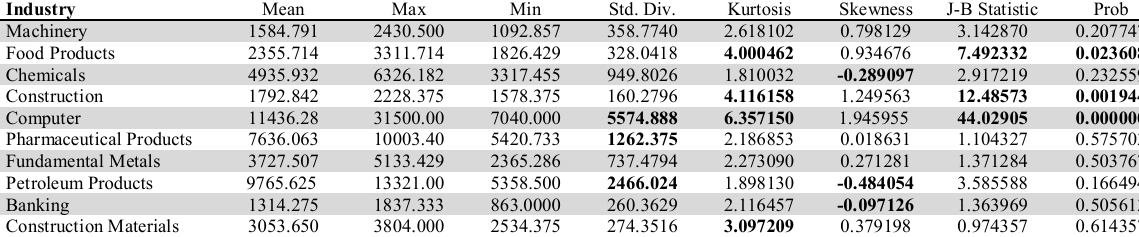
Industry stock price time series descriptive statistics